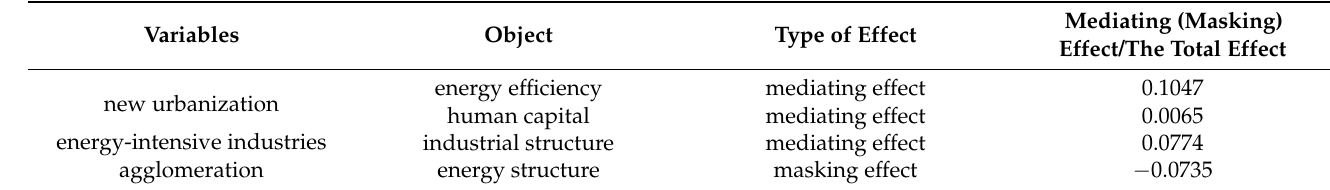
Table 7. Summary of the mechanism